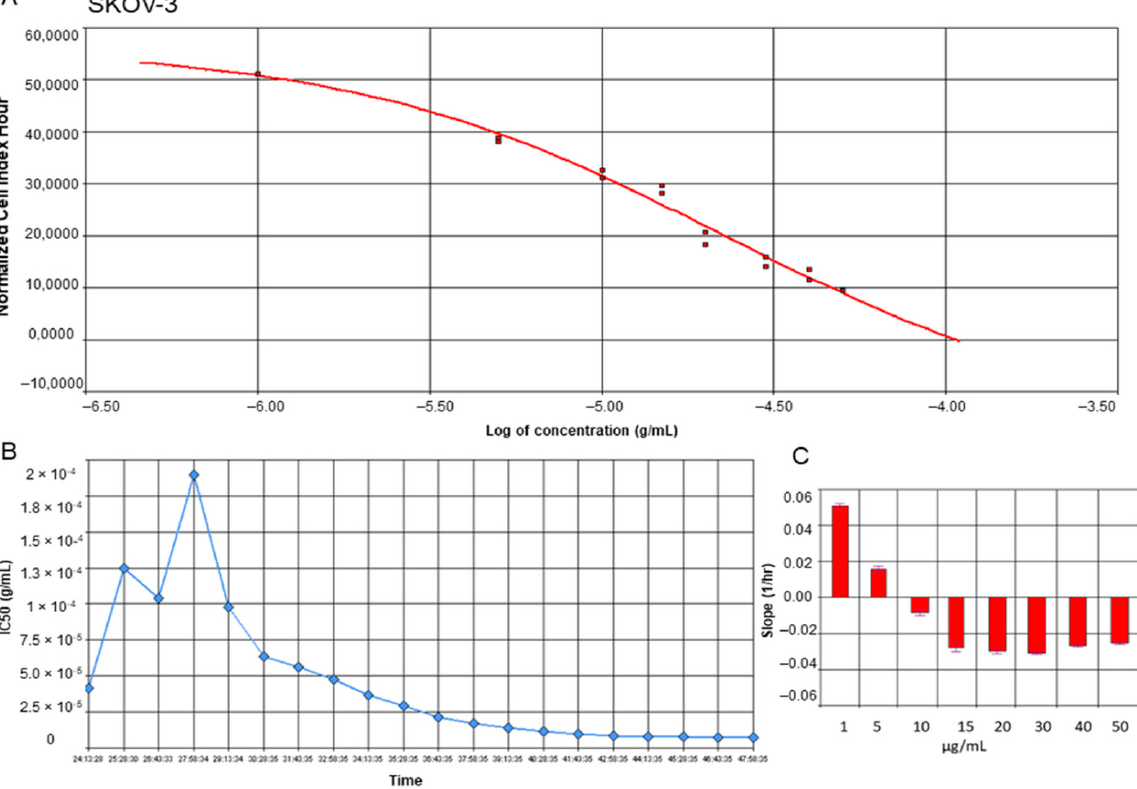
Figure 2. RTCA profiles of cell index ( A ), IC 50 values ( B ), and slope of changes ( C ) in cytotoxic effect of yamogenin on the SKOV-3 cells. The cells were incubated with the compound for 24 h, and normalized cell index vs. concentration of yamogenin was calculated by RTCA system ( A ). The IC 50 values of yamogenin were obtained at every time point of the experiment (every 30 min) ( B ). The slope of changes in cytotoxic effect of yamogenin was calculated for every used concentration of the compound during the experiment ( C ). The results were obtained in three independent exper- iments. Error bars represent standard deviations.